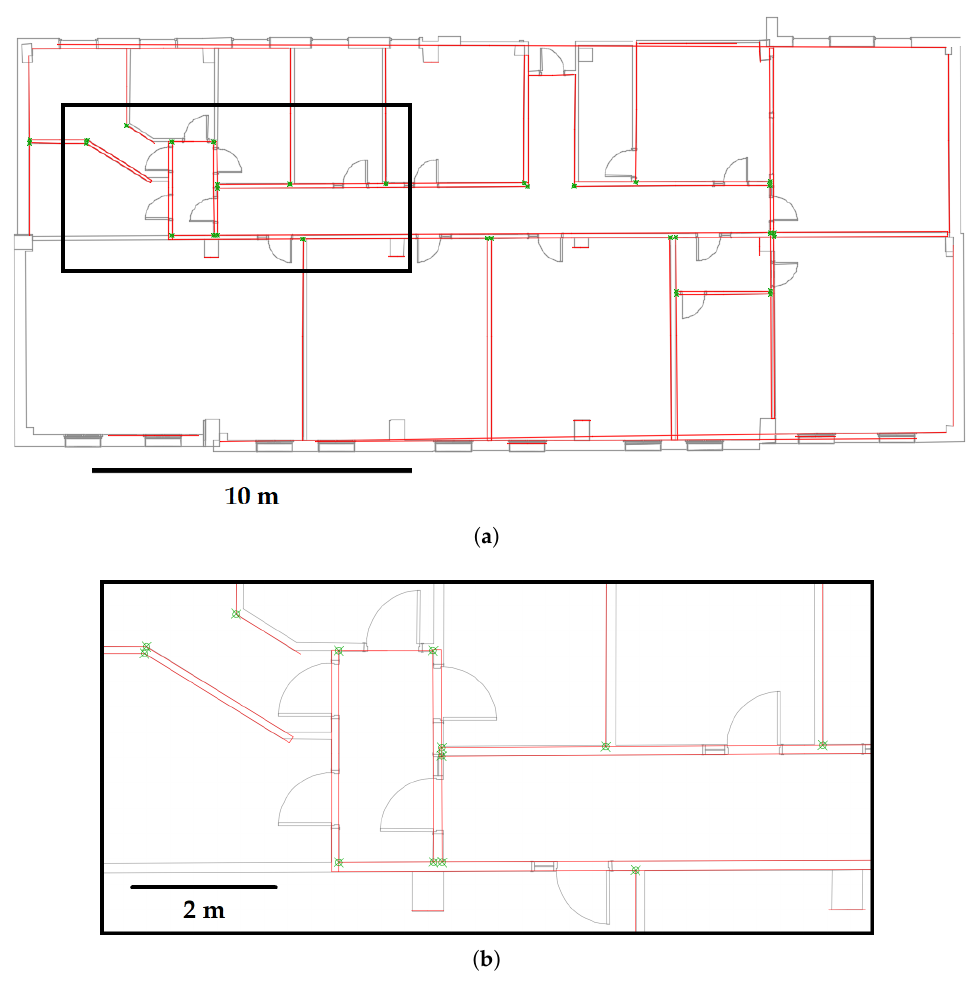
Figure 15. ( a ) Superimposition of obj file (in red) with a 2D floor plan in dwg format—2nd floor of the office building. ( b ) Zoom on the